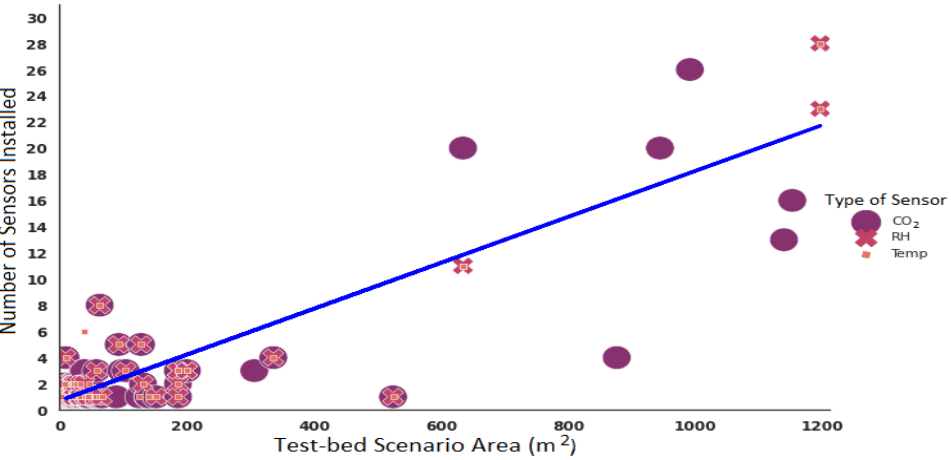
Figure 18. Proposed linear regression to calculate the number of sensors per